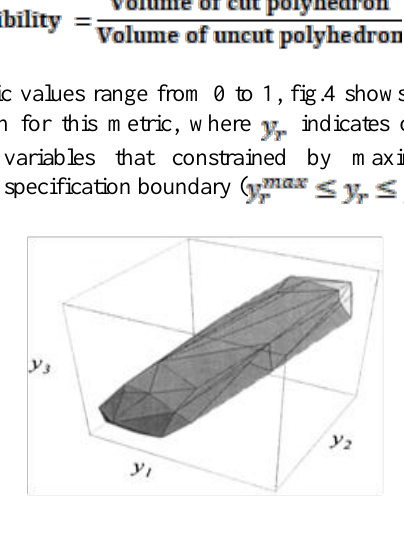
Figure 4. Illustration of the flexibility